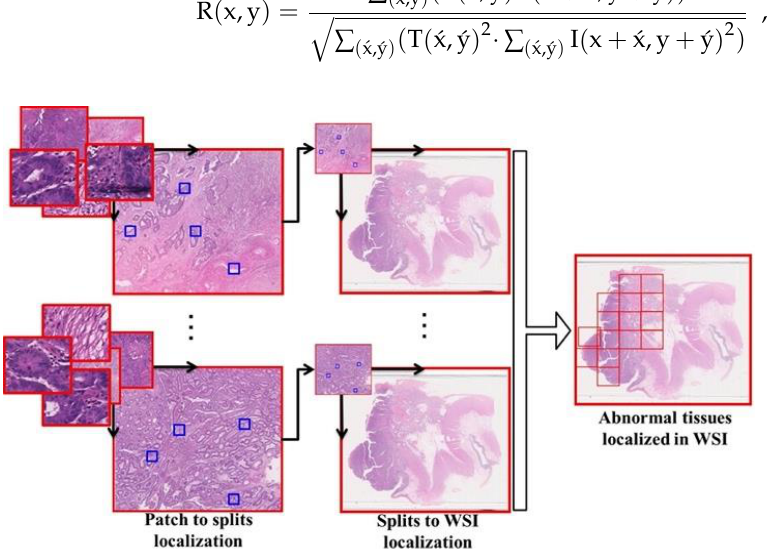
Figure 4. Overall localization in WSI.